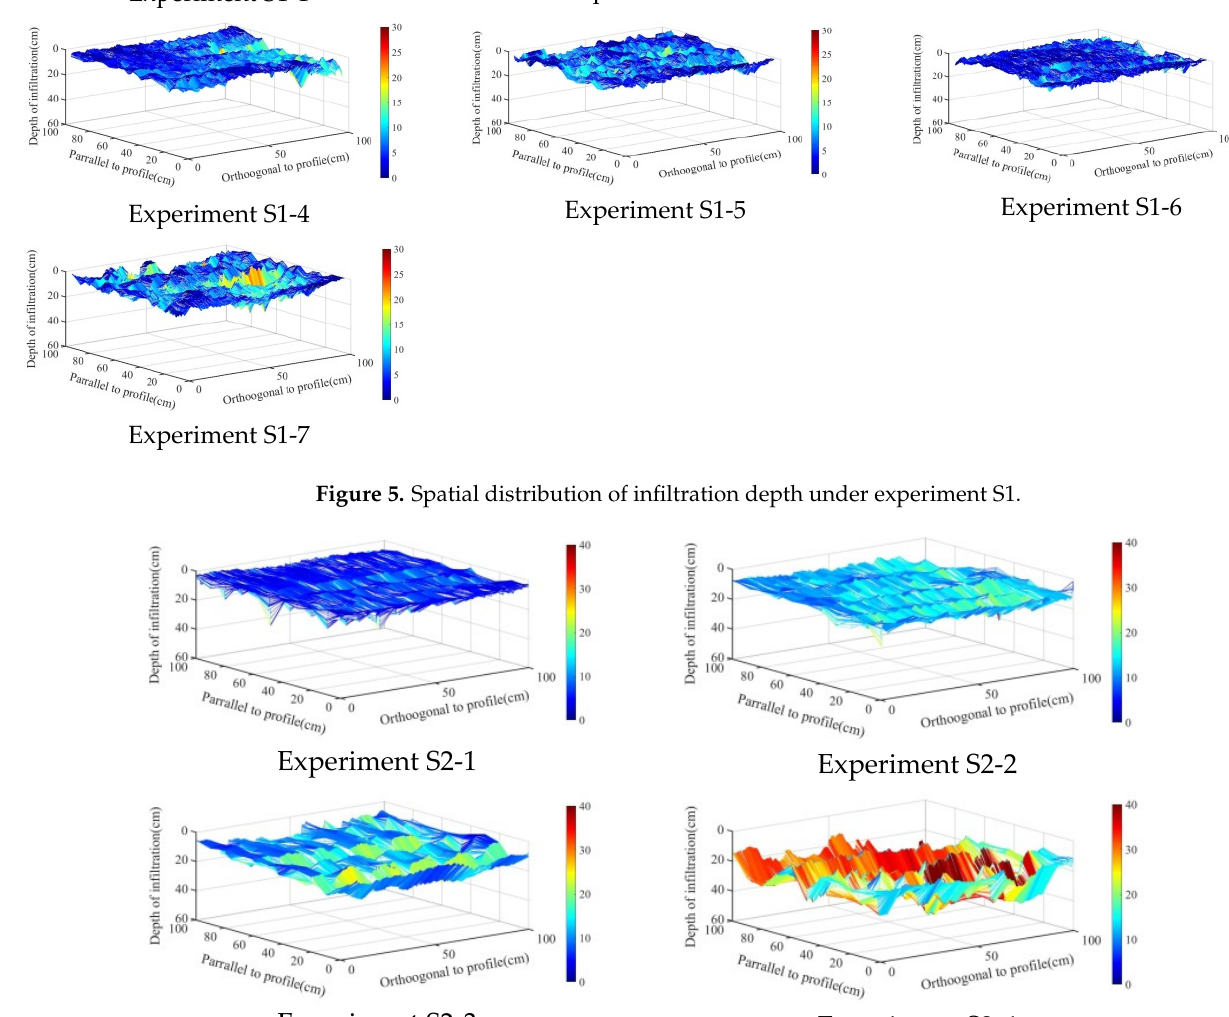
Figure 6. Spatial distribution of infiltration depth under experiment S2.